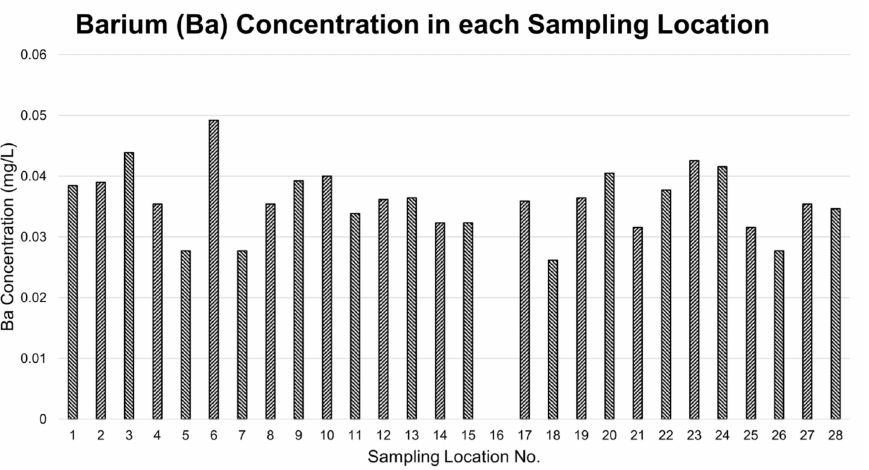
Figure 3. Concentration of Ba in GW samples.